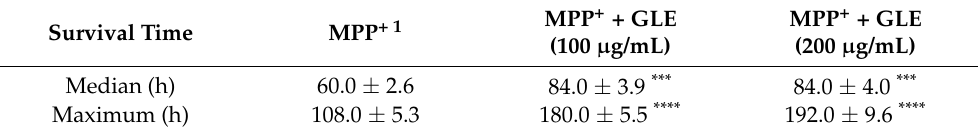
Figure 4. Effect of GLE on MPP + -induced neurotoxicity in daf-2 mutant C. elegans . ( A ) Lifespan curve of worms in the presence or absence of MPP + . ( B ) Lifespan curve of worms with MPP + -induced toxicity treated with 100 µ g/mL GLE. ( C ) Lifespan curve of worms with MPP + -induced toxicity treated with 200 µ g/mL GLE. Each experiment was repeated independently at least thrice, and one of the representative data is shown. Table 3. Survival of daf-2 mutant C. elegans treated with MPP + .